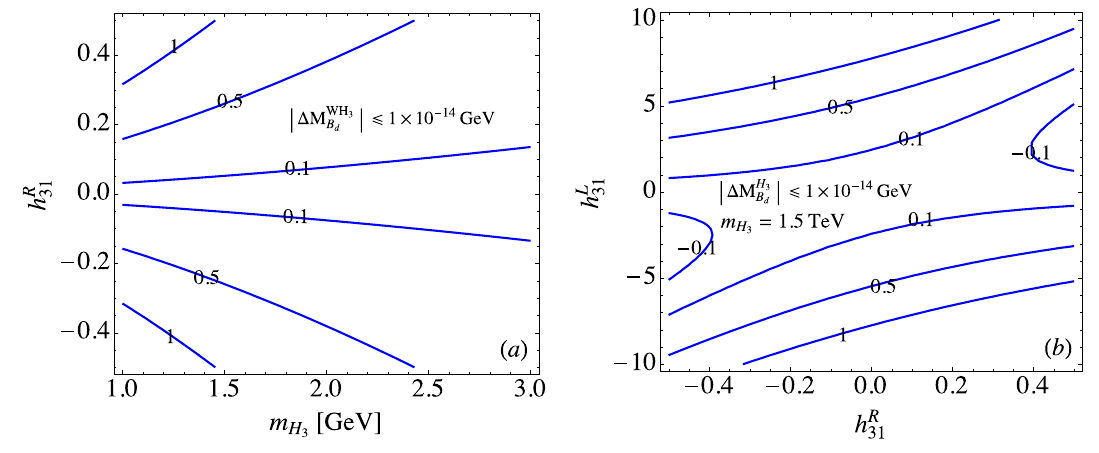
Figure 7 . (a) Contours for (cid:1) M WH 3 Contours for (cid:1) M H 3